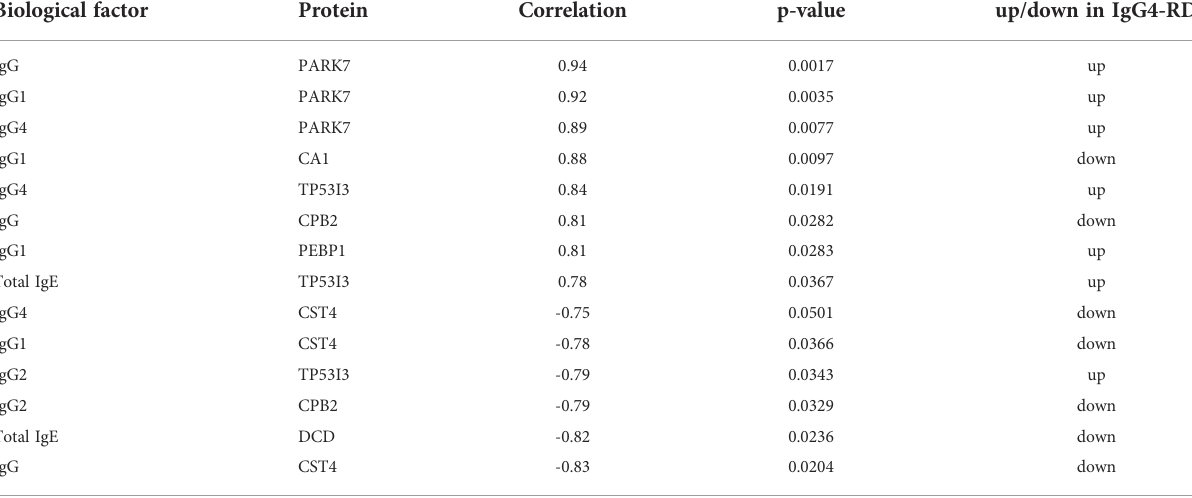
Biological factor Protein Correlation p-value up/down in